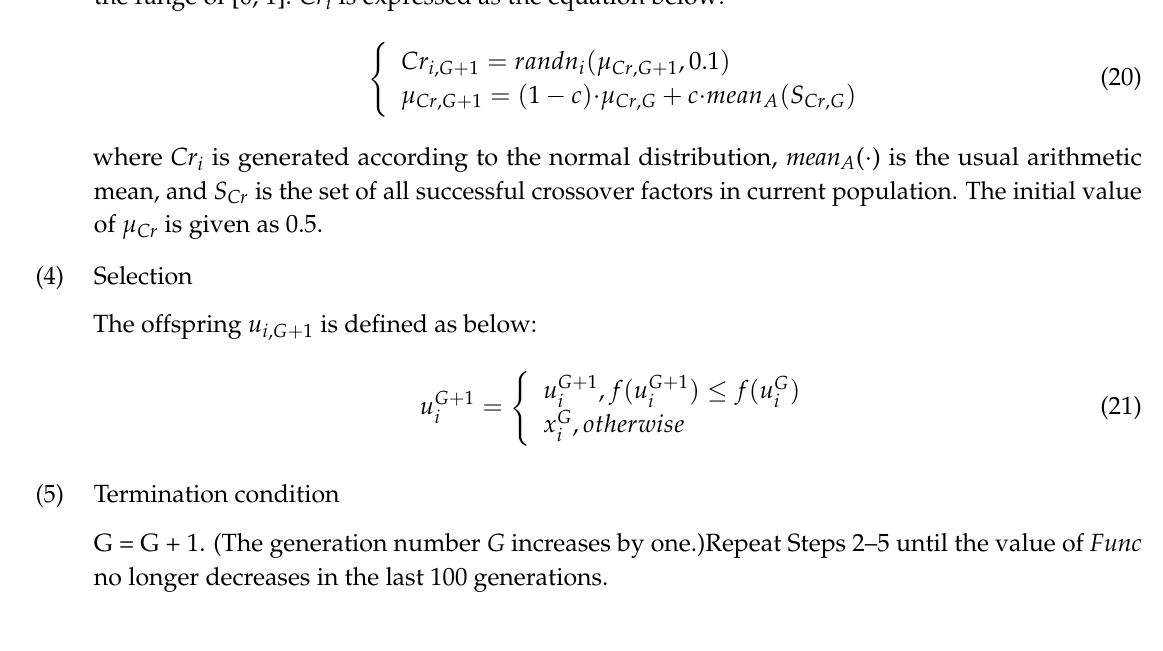
Figure 6. 3D measurement model.